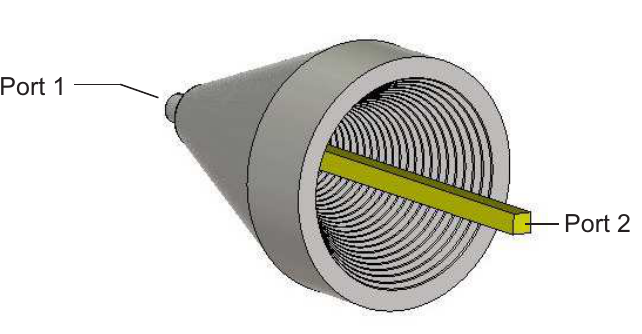
Figure 19. Transition simulation model.